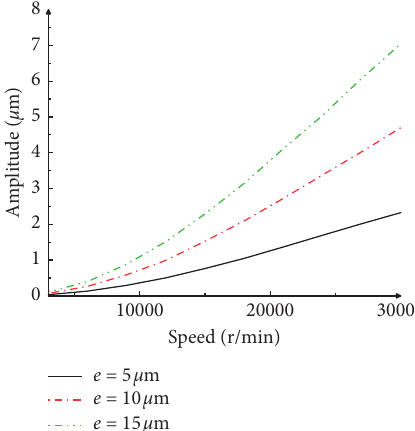
Figure 9: Effect of mass eccentricity on amplitude without static